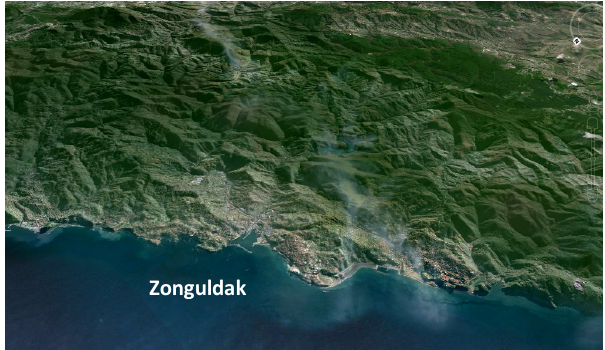
Figure 2. Zonguldak city centre and its hinterlands in Google Earth.